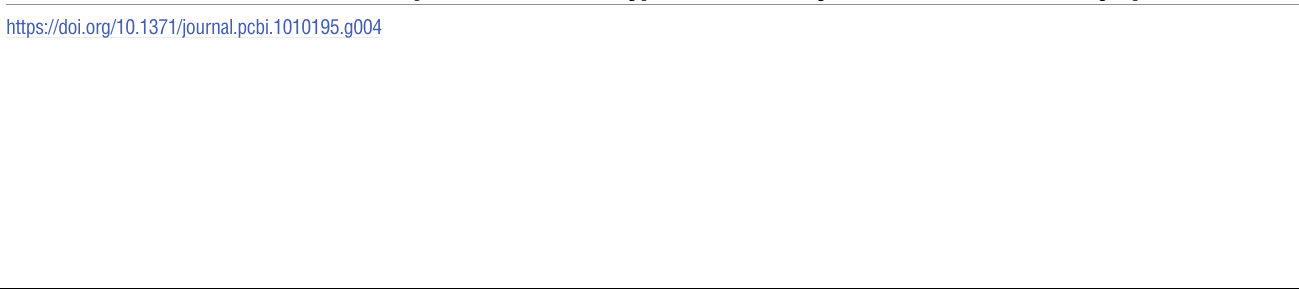
PLOS Computational Biology | https://doi.org/10.1371/journal.pcbi.1010195 June 2, 2022 8 /